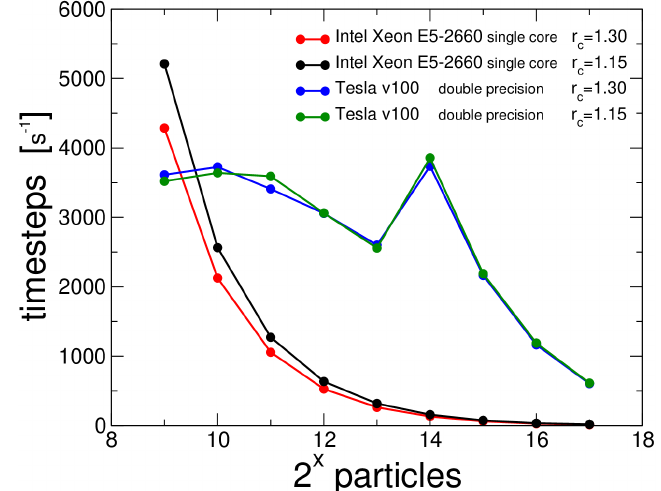
Figure 8: Computational time required by our HOOMD-blue implementation of the three-body swap potential. We test mixtures of N = 2 x dumbbells introduced in the paper, ranging from x = 9 ( N = 512 ) to x = 17 ( N = 131072 ) . We also test the effect of a reduction of the cutoff radius r that limits the number of interacting c triplets. Only for very small system size ( N < 1000 ) the CPU (Intel Xeon E5-2660) is faster than the GPU (Tesla v100). In this worst case scenario of a system where every particle interacts with the three body potential, as soon as N > 1000 the GPU becomes almost two times faster than the CPU. This speed up factor provided by the GPU grows for larger systems, reaching and surpassing a factor of ∼ 30 at N ∼ 15000, confirming that the GPU architecture is optimal for larger systems that capitalize on parallel